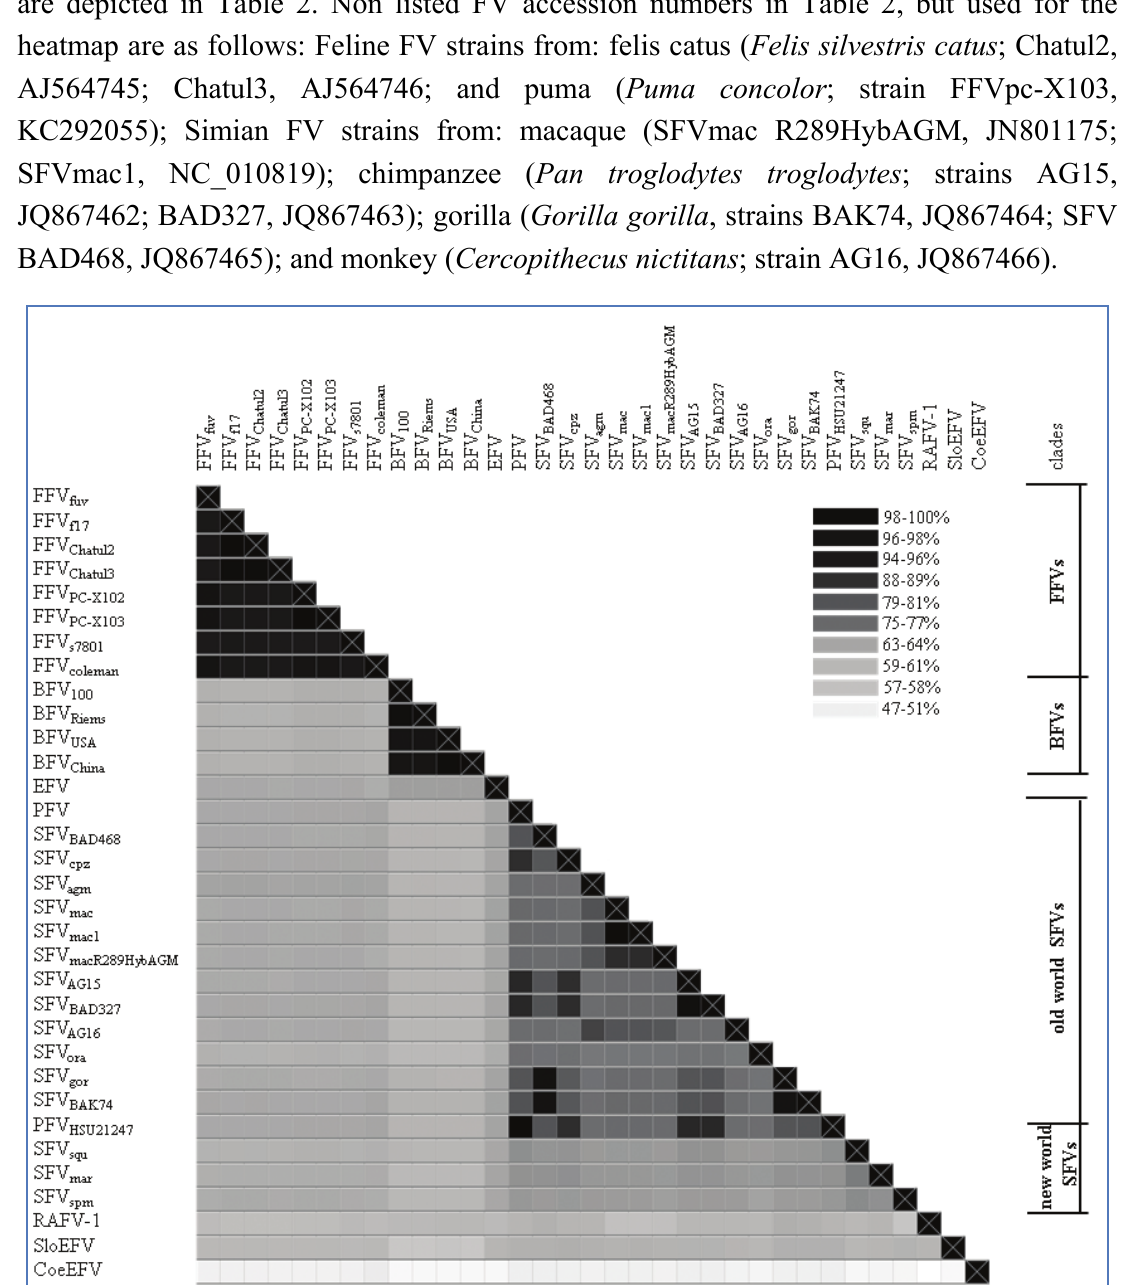
Figure 2. Genomic pol alignment of FV types and isolates with a complete pol sequence, excluding the bat FV RaFV-1: The alignment is visualized as a heatmap displaying the sequence identity (% of identical residues) among the different FV types/isolates as grey-scales. The color scheme is computed as a continuum of grey scale colors from light grey to black as indicated in the legend and correlates to the percentage of sequence identity as mentioned above. On the right of the heatmap a separation between the different FV clades is displayed as bars; single isolates have been left blank. Nucleotide sequence alignment was done using a progressive pairwise alignment method built in the Geneious 6.05 software tool available from Biomatters [44]. Accession numbers used for phylogeny are depicted in Table 2. Non listed FV accession numbers in Table 2, but used for the heatmap are as follows: Feline FV strains from: felis catus ( Felis silvestris catus ;